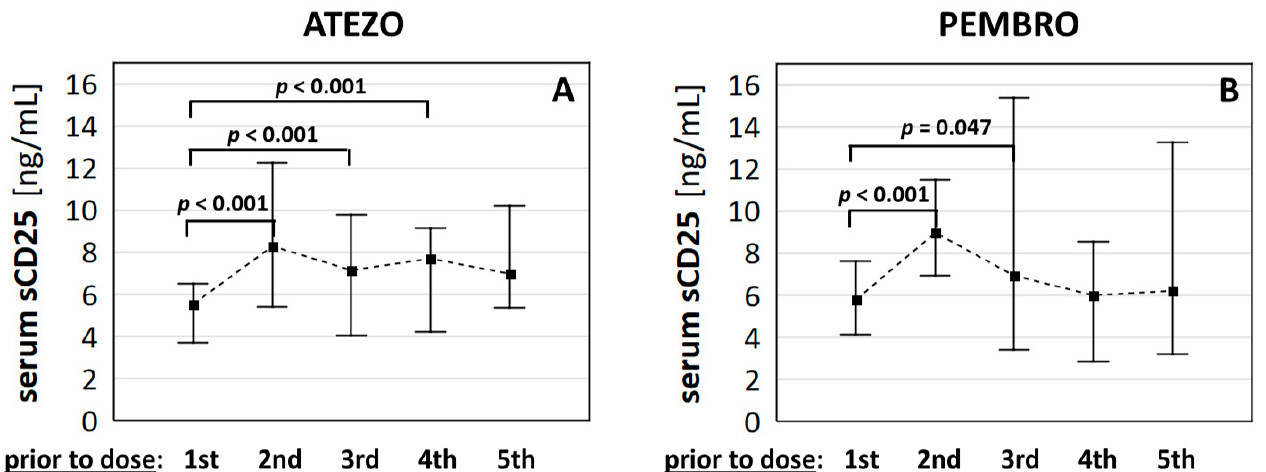
Figure 1. Changes in serum sC25 during the first four cycles of immunotherapy with anti-PD-1/PD-L1 drugs. Figure presents medians (filled squares) and interquartile ranges (whiskers) of sCD25 protein in subjects with NSCLC receiving ( A ) ATEZO and ( B )